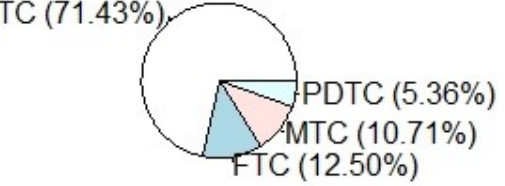
Figure 3. Pie Chart showing the different histotypes of cancer treated; the prevalence was 71.43% ( n = 40) Papillary Thyroid Cancer (PTC), 12.50% ( n = 7) Follicular Thyroid Cancer (FTC), 10.71% ( n = 6) Medullary Thyroid Cancer (MTC) and 5.36% ( n = 3) Poorly Differentiated Thyroid Cancer (PDTC).